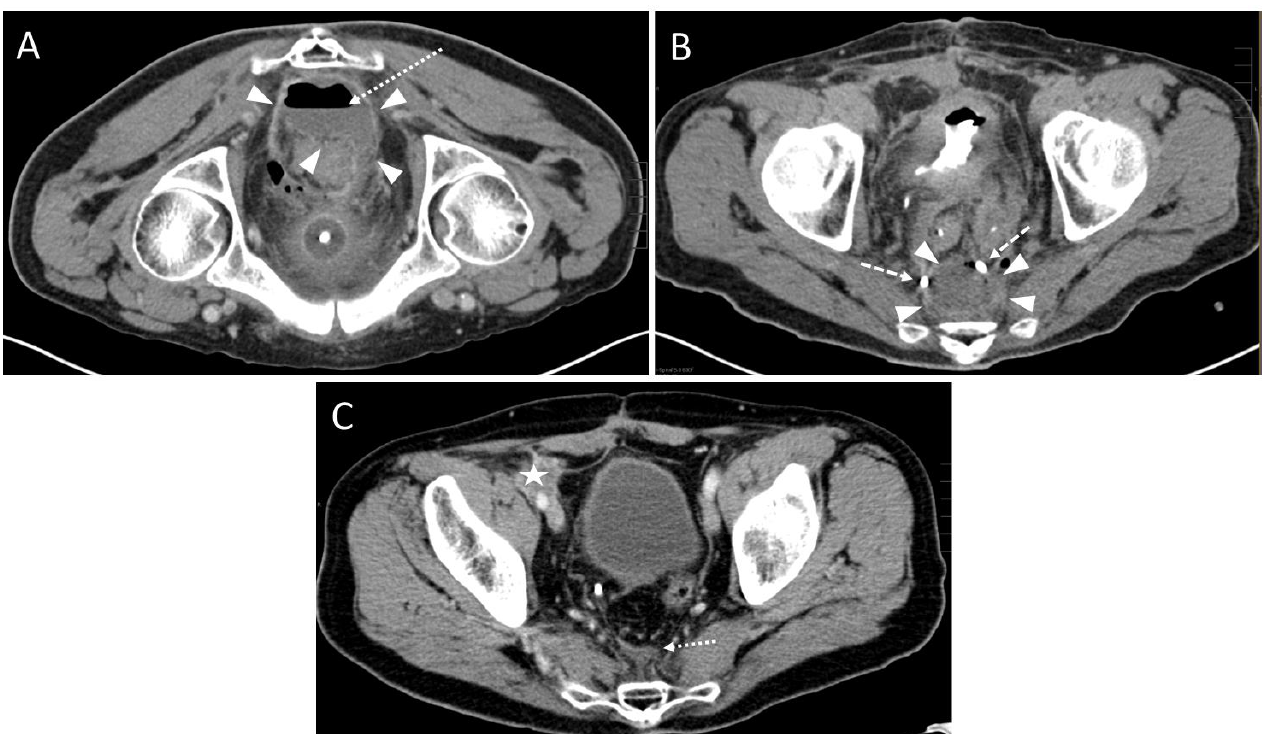
Figure 4. A 67-year-old male with a history of rectal carcinoma (T4 tumor stage) after deep anterior rectal resection including total mesorectal excision and the creation of a loop-iliostomy. In addition, a ureter reimplantation due to tumor infiltration in the bladder and an iliac lymph node dissection was performed. Five days after the operation a small anastomotic insufficiency was diagnosed and treated by flushing. Three weeks later a CT fluoroscopy-guided drain placement was performed due to recurrent fever spikes up to 38.5 degrees. ( A ) A preinterventional scan showed a presacral fluid collection (arrowheads) with air/fluid level (dotted arrow). ( B ) After the CT fluoroscopy-guided insertion of an 8 F drain, purulent fluid could be partially aspirated and a postinterventional control scan showed a moderate reduction of the abscess formation (arrowheads). Dashed arrow: loop-formation of the distal drain segment. ( C ) After one year, the complete resolution of presacral abscess formation was observed. Dotted arrow: small scar tissue. However, a newly appeared soft tissue mass in terms of a peritoneal tumor relapse occurred in the right parailiac region (asterisk).